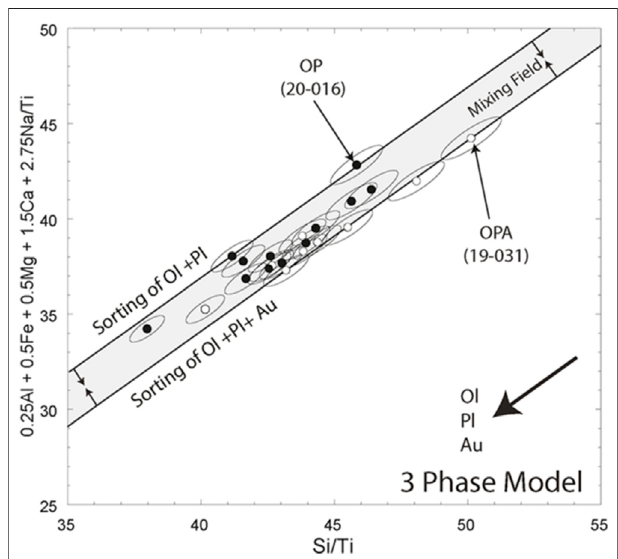
FIGURE7 | Assemblage test diagram for thephenocryst assemblage of olivine + plagioclase + clinopyroxene (the same symbols as in Figure 6 ). A modellinewithaslopeof1isprojectedthrougheachdataset ’ smostprimitive point. Here the most primitive samples of each assemblage suite (20- 016, OP) (19-031, OPA) de fi ne upper and lower trend boundaries where all other CM samples fall between. The trend in data suggests sorting of phenocrysts combined with syn-eruptivemixing ( fi eld shown in grey) between the two distinct petrographic suites.